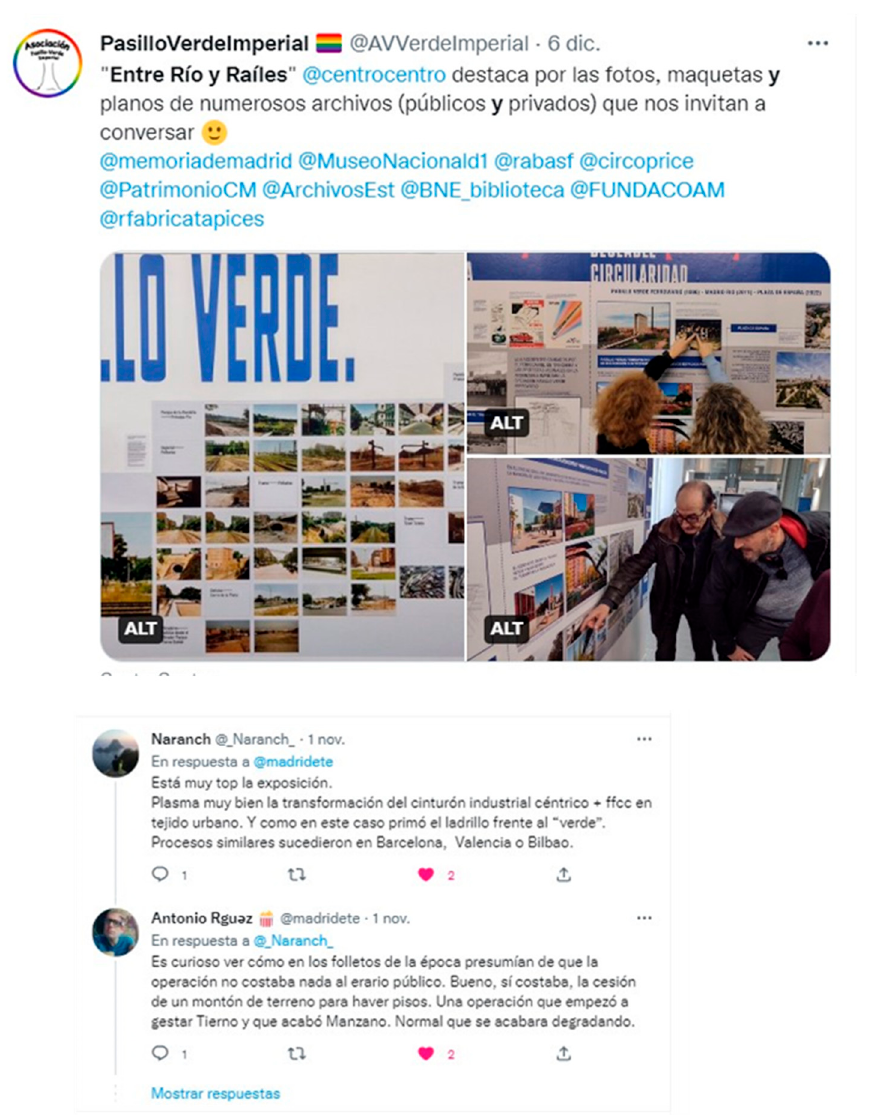
Figure 14. Twitter thread by the Asociación Pasillo Verde Imperial that included photos of neighbors visiting the exhibition. A debate was generated around the “zero cost” management model and the state of abandonment. Two neighbors indicated the photo of the authorities in the presentation of the PVF model. Among the comments can be read the following: Naranch replying to @madridete: “The exhibition is very top. It captures very well the transformation of the downtown industrial belt +ffcc into urban fabric. And how in this case, brick prevailed over ’green’. Similar processes took place in Barcelona, Valencia or Bilbao.”; Antonio Rguaz: “It is curious to see in the brochures of the time how they boasted that the operation did not cost the public treasury anything. Well, it did cost the transfer of a lot of land to build flats. An operation that Tierno (Enrique Tierno Galv á n) began to develop and that Manzano ended. No wonder it ended up